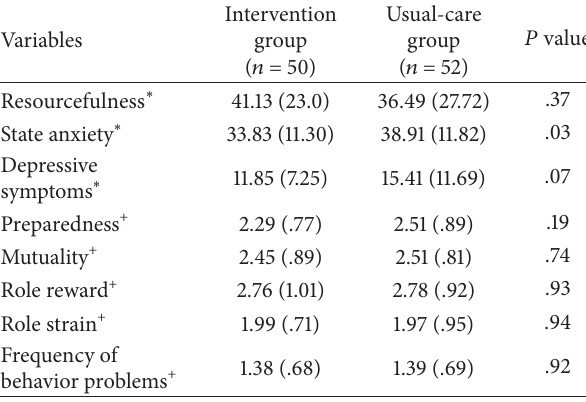
Table 3: Family caregivers’ baseline data for dependent